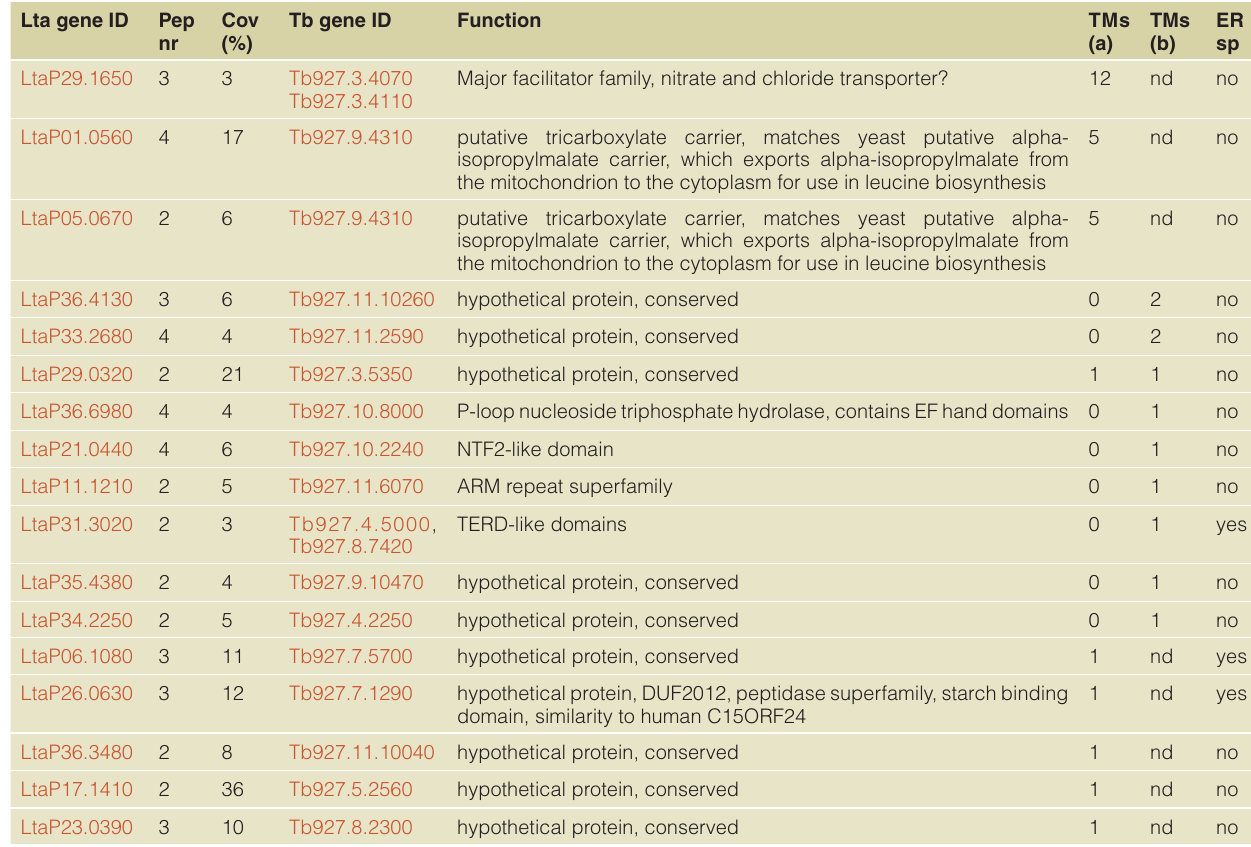
Table 2. Possible additional glycosomal membrane proteins. This list includes all detected proteins with predicted trans-membrane (TM) domains, for which there is no evidence for location in any particular compartment. Lta gene